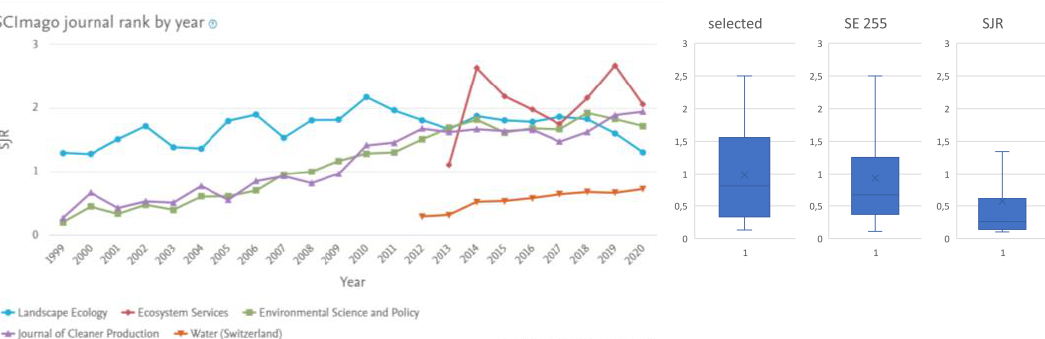
Figure 7. Evolution of the SJR index of the main journals in the selected sample ( right ) and box plot graphics of all publications registered in Scimago (SJR) and “water SE” and selected samples ( left ). Adapted from Scopus and SCImago 2020.